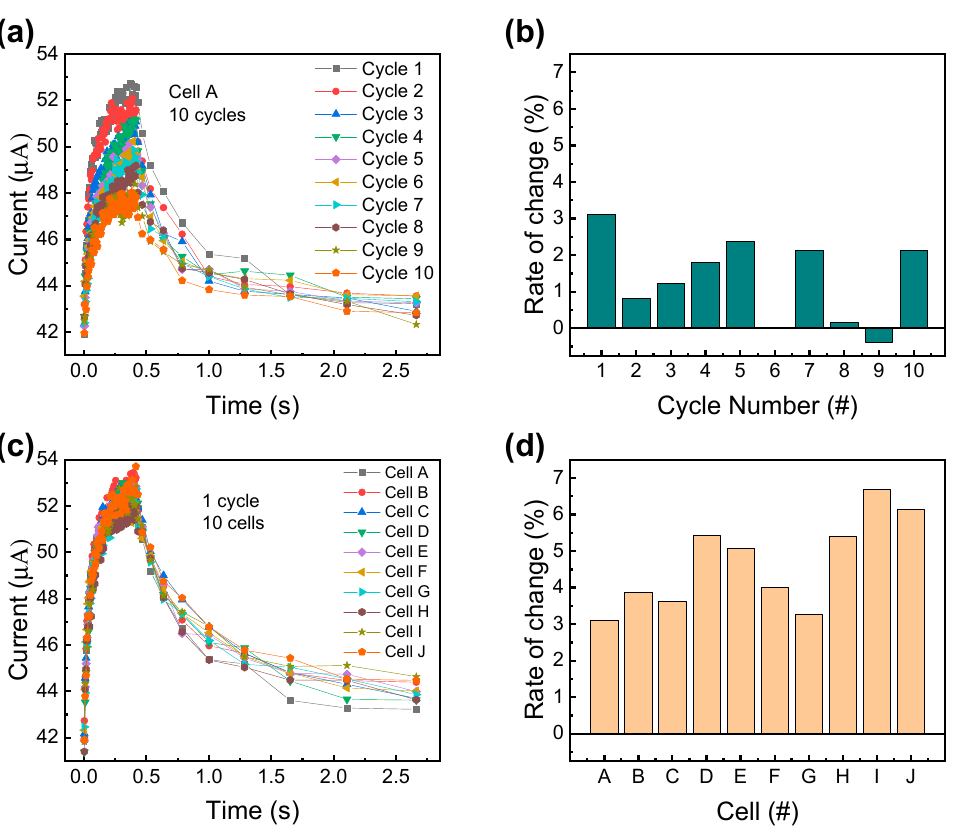
Figure 4. Accumulation and decay curves of the Pt/HfO 2 /TaO x /TiN RRAM device. ( a ) Cycle-to-cycle variation and ( b ) their change rate. ( c ) Cell-to-cell variation and ( d ) their change rate.